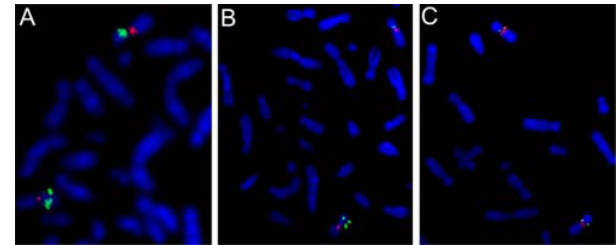
Figure 3. Validation of amplicons by FISH analysis on cell lines. Identification of increased copies of signals of the BAC clone RP11- 165H19 mapped to 9p13.3 amplicon in cell line CWR22 and CWR22-Rv1 (A and B). C Optimal signal and lack of cross hybridization was verified using normal metaphase spreads showing two signals for each probe. BAC clone RP11-165H19 signals are green; red signals indicate chromosome 9 centromere (D9Z1).